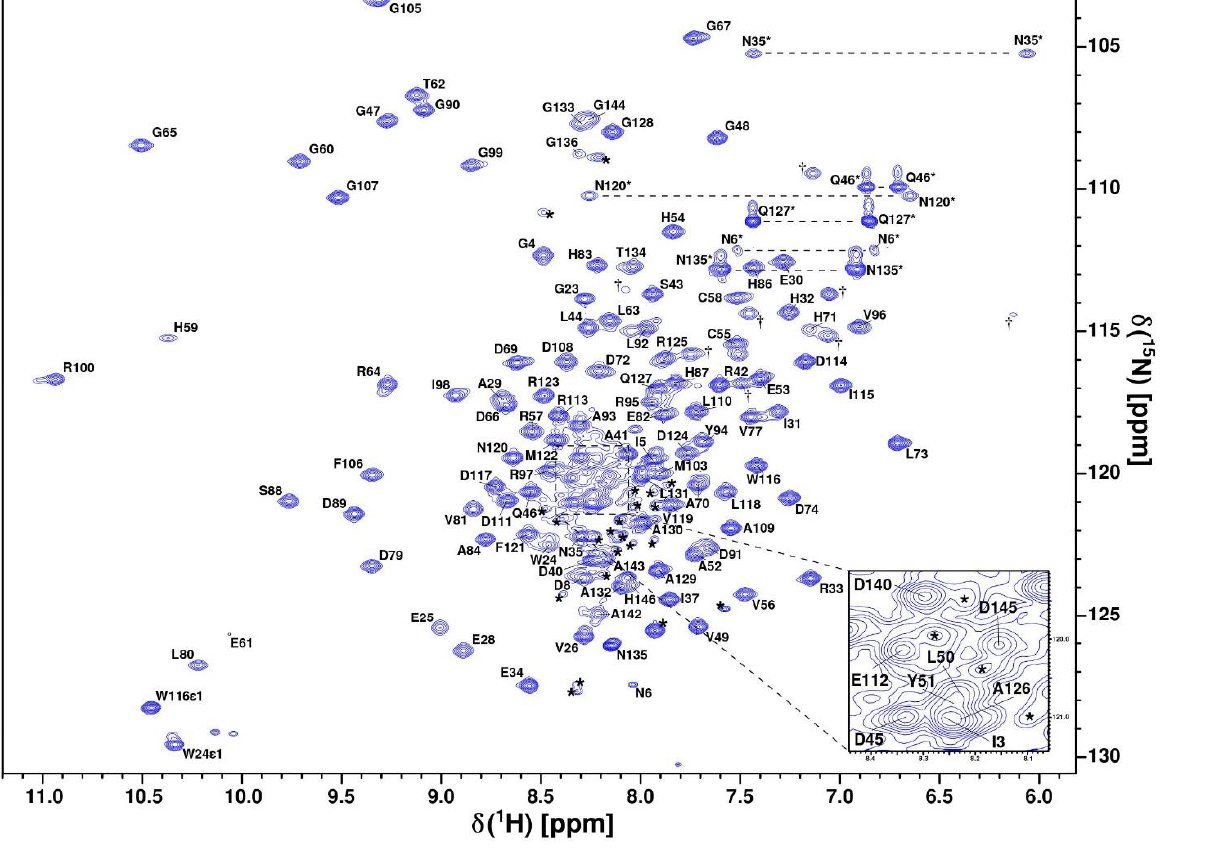
Figure 2. Assigned 1 H- 15 N-HSQC spectrum of uniformly 13 C/ 15 N-labeled oxidized CytC552 recorded at 800 MHz resonance frequency, pH 7.0, and 303 K. Cross-peaks of side-chain NH 2 groups of Asn and Gln are connected by dashed lines and marked by asterisks. Side-chain Hε–Nε correlation peaks of Arg are marked with dagger signs ( † ). Unassigned cross-peaks are indicated by asterisks.